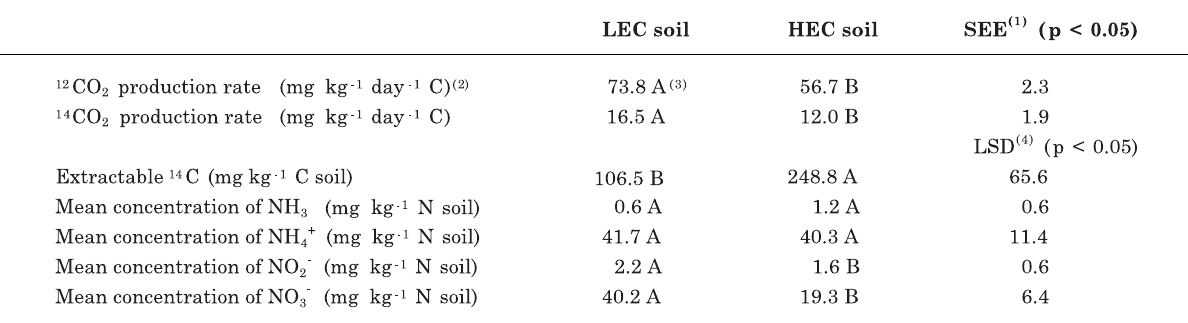
- and NO - in LEC and HEC 2 3